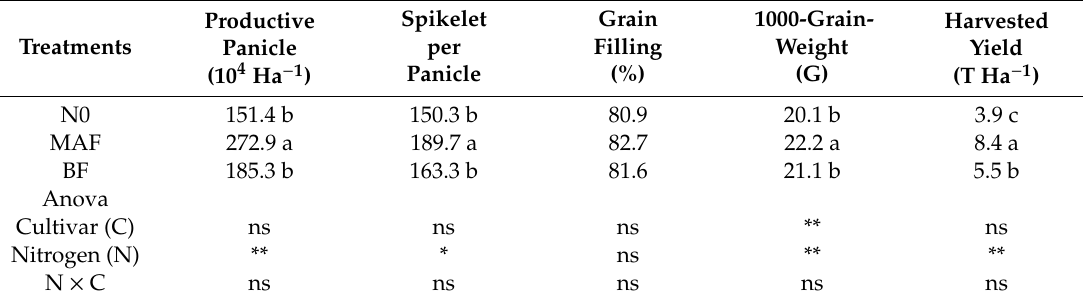
Table 1. E ff ects of mechanical deep placement of nitrogen fertilizer on average grain yield and its components for both rice cultivars in two-year (2018 and